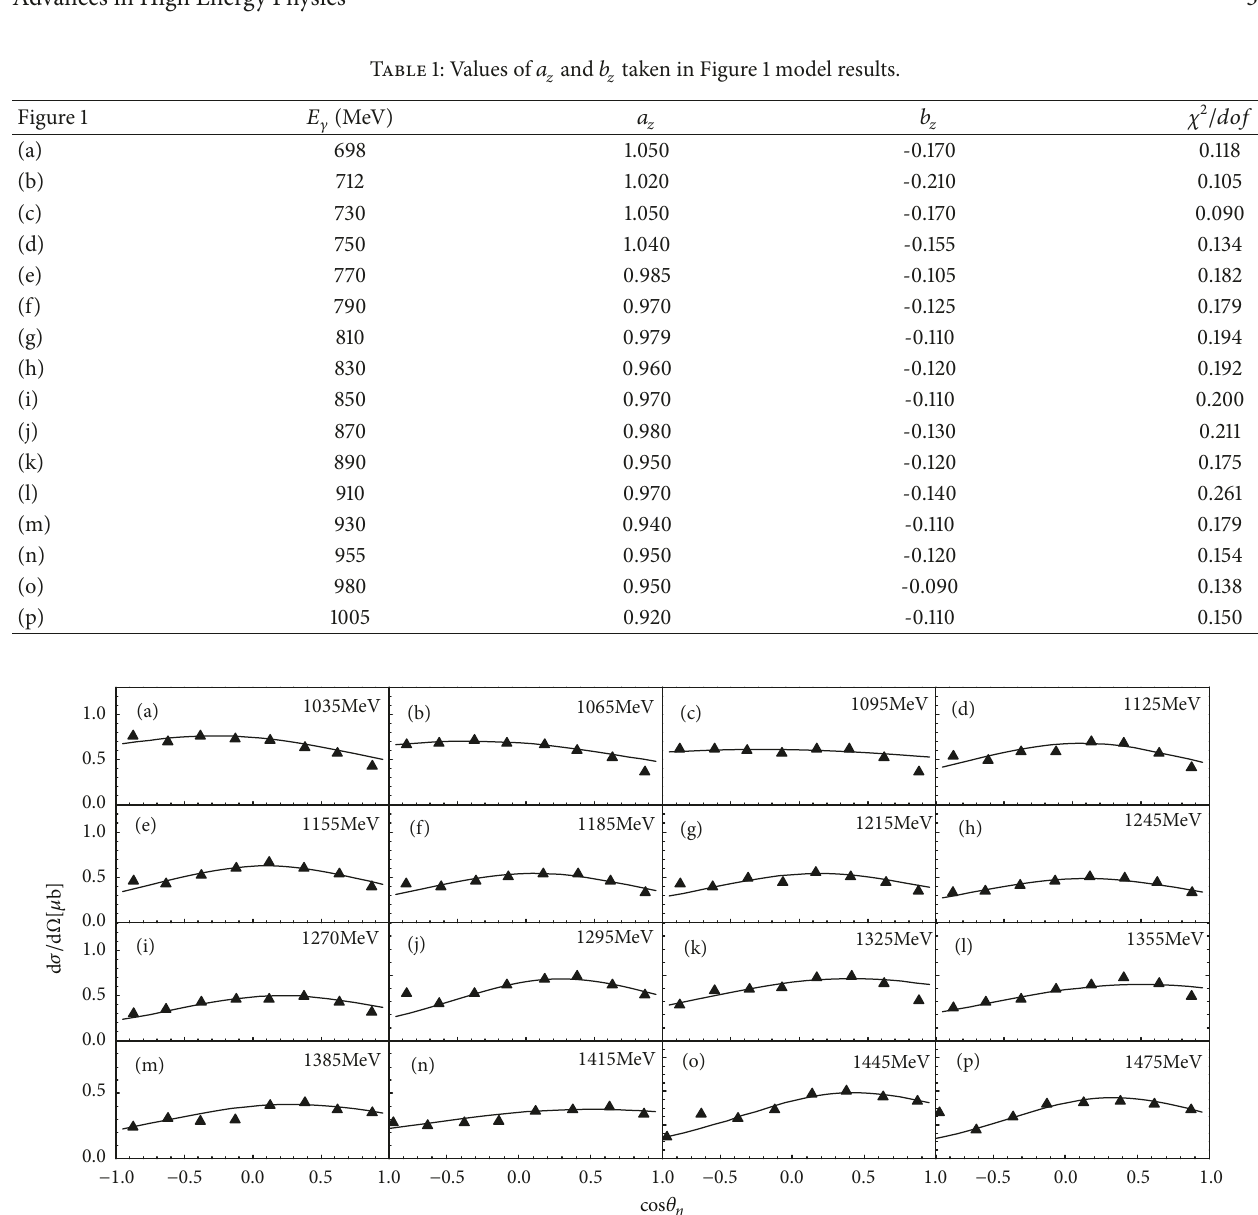
2, the schematic sketches of the emission sources are given at different energies in Figures 7(b) and